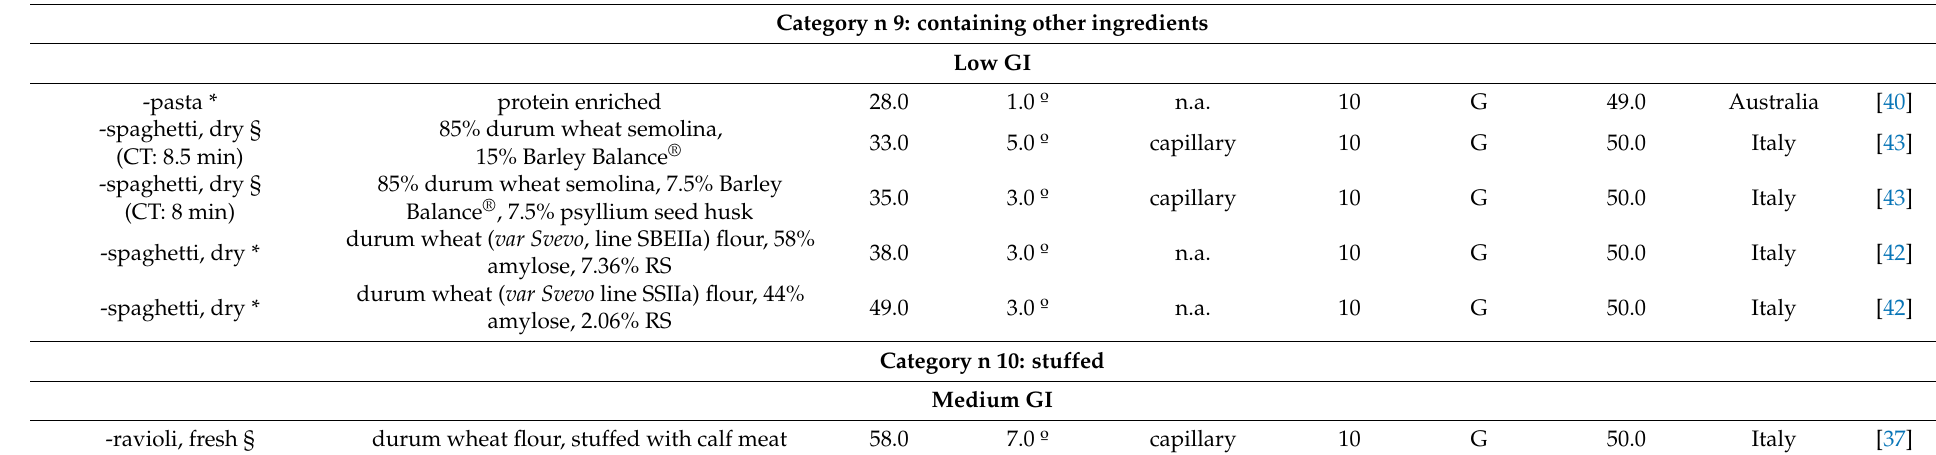
Table 1. Pasta product characteristics, glycemic index and experimental protocol data. Pasta Product Characteristics